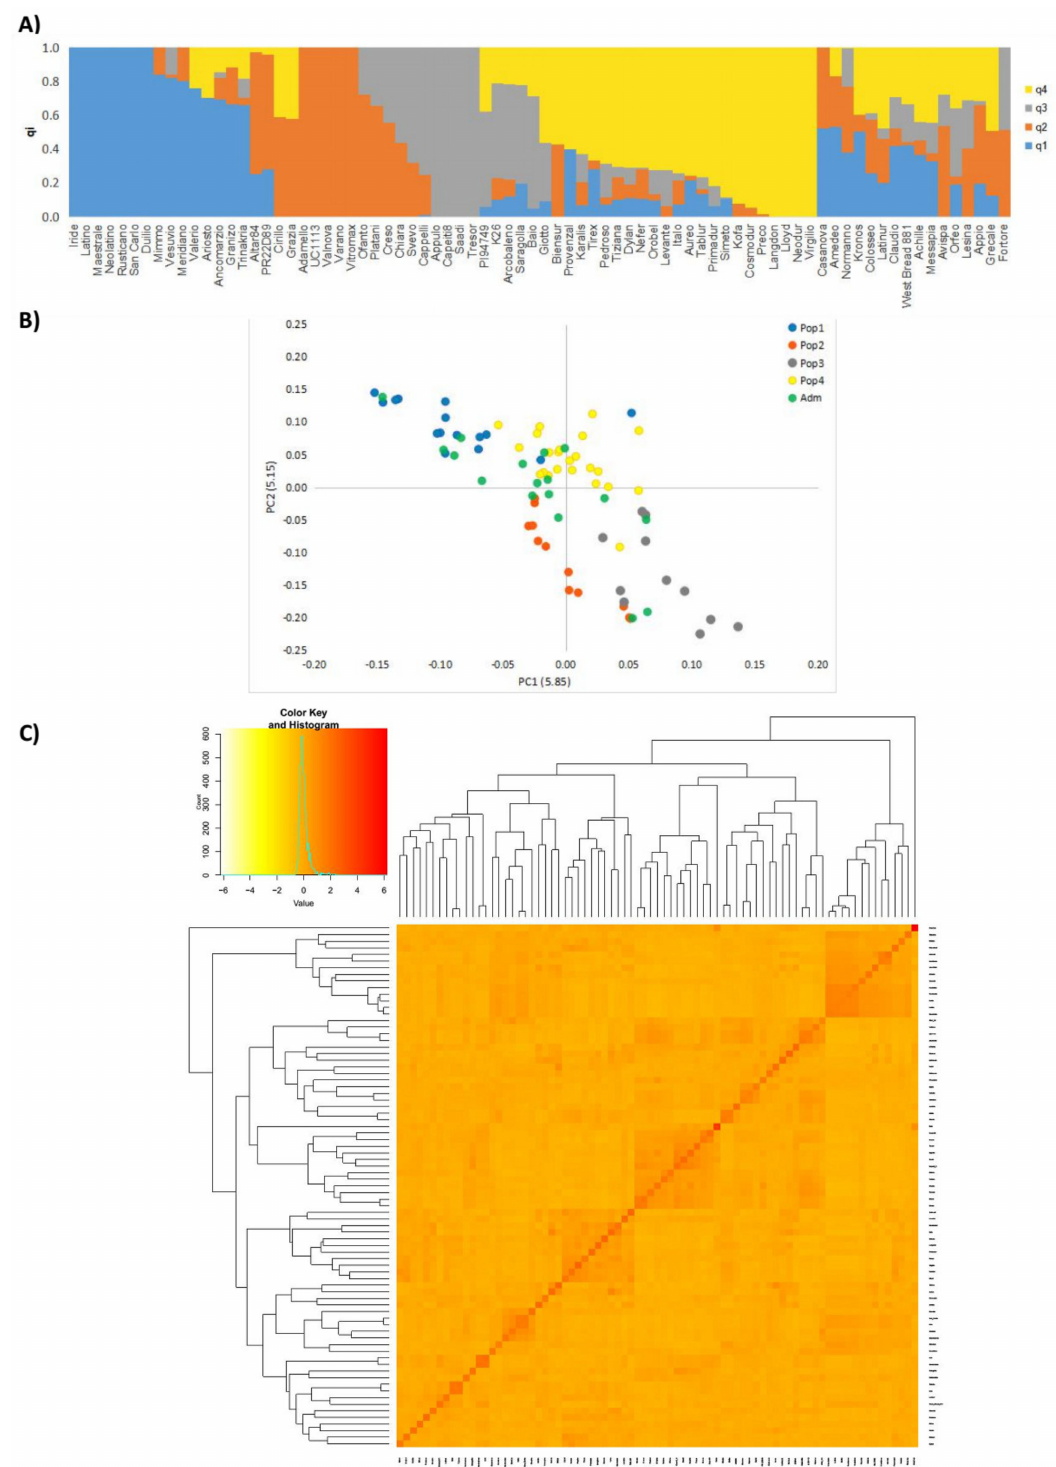
Figure 4. Population structure using 2628 single nucleotide polymorphism (SNP) markers. ( A ) Bar-plot describing the population structure at K = 4. Each accession is represented by a bar, which is partitioned into four colored segments whose length is proportional to the estimated membership coe ffi cient (q i ). ( B ) Scatter plot of the top two principal coordinates (PC1 and PC2). Accessions are colored according to the sub-population they were assigned to by ADMIXTURE at K = 4. ( C ) Heatmap and dendrogram of a kinship matrix estimated using GAPIT. Colors show the distribution of values of relatedness in the whole kinship